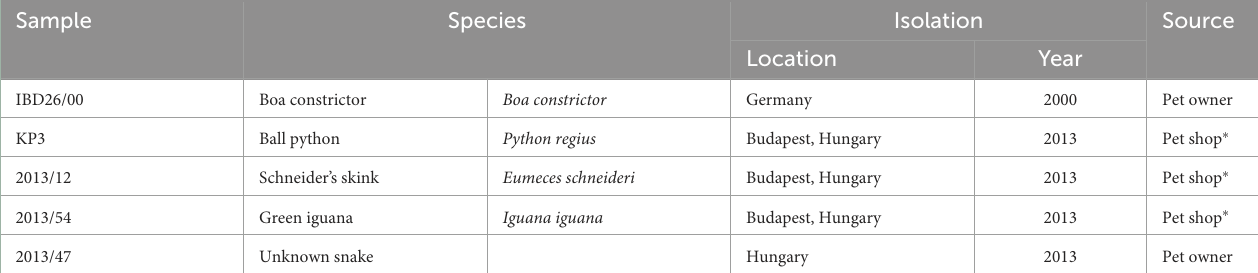
TABLE 1 List of virus strains analyzed in the current study.